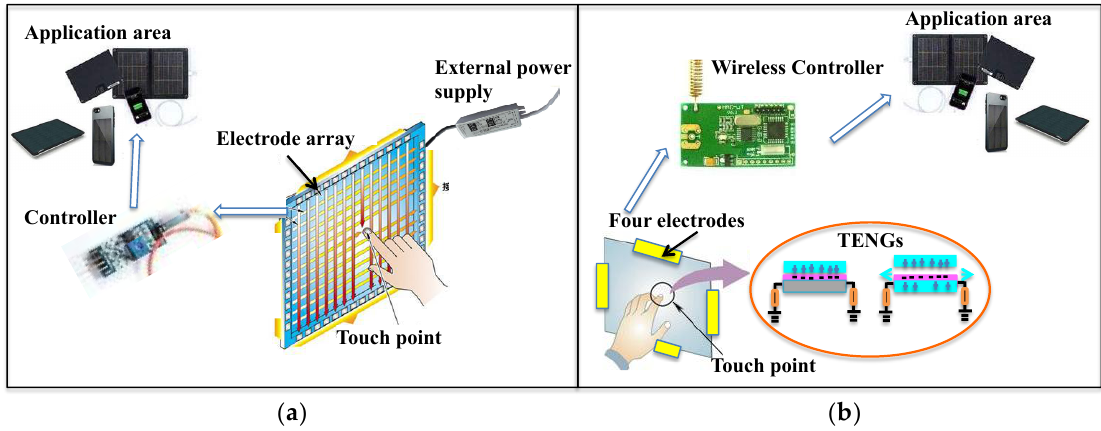
Figure 1 . ( a ) The traditional tactile sensing system which requires external power supply and large number of sensors and electrodes to achieve high resolution; ( b ) Self-powered electronic system by the integration of flexible tactile sensor with only four electrodes and energy harvesting.